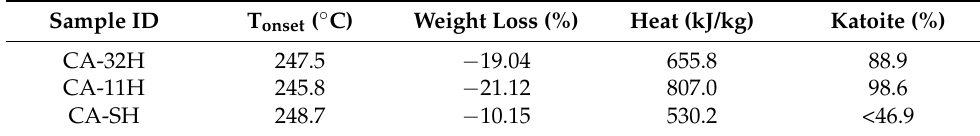
Table 4. Thermogravimetric analysis (TGA) and DSC characterization results.